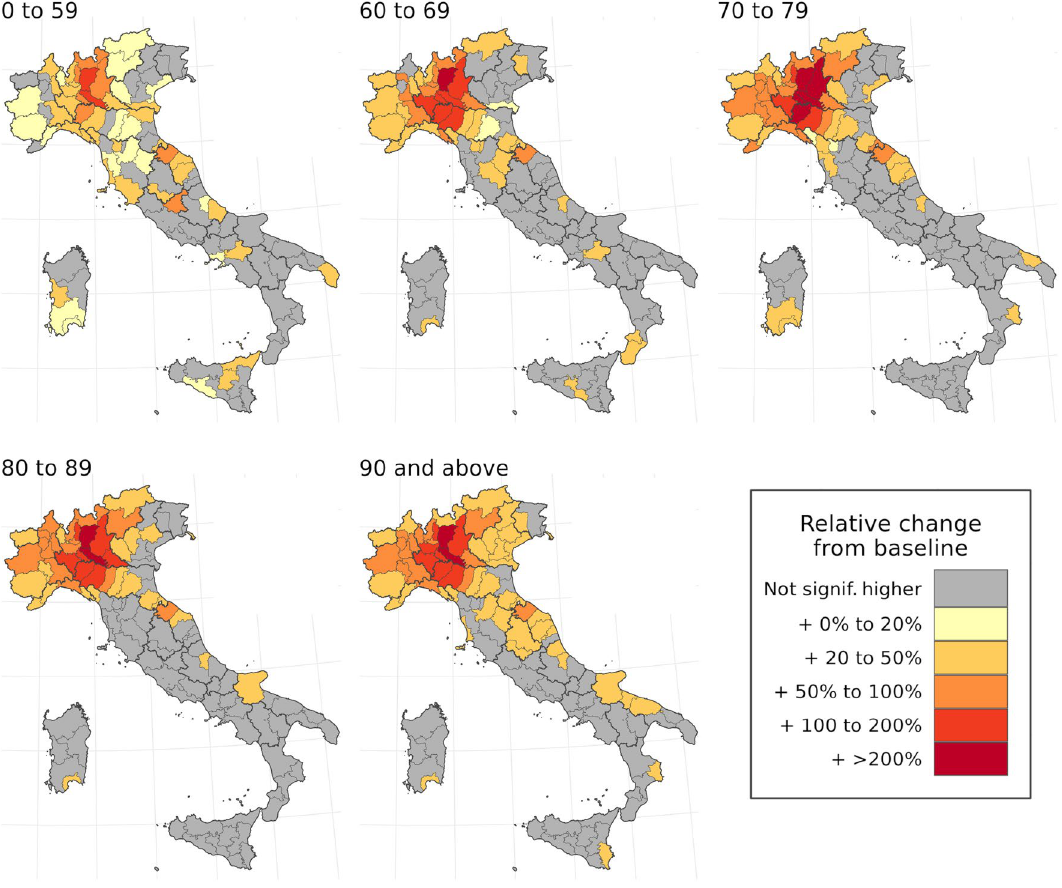
Figure 4. Map of standardized mortality ratios by age group and province over the entire period of March through May 2020. In these figures, significance is defined as falling outside of the 95% uncertainty interval for baseline mortality for a given age group and province during this Figure 4 maps the standardized mortality ratio, or the ratio between observed and baseline mortality rates, by age group and province across the entire 13-week period from 26 February through 26 May 2020. Note that the standardized mortality ratio uniformly increases across the northern provinces of Italy when moving from the 0–59 age group to the 60–69 and 70–79 age groups, and remain heightened in the oldest age groups, with some provinces in Lombardy and Emilia Romagna experiencing over three times the expected baseline mortality in older age groups. The greater increase in excess mortality among older age groups can also be expressed by com- paring the proportion of excess mortality with each age group with that age group’s share of all-cause mortality in the years 2015 through 2019. Adults over age 60 accounted for 92.6% of all deaths in the years 2015–2019 (2.99 million deaths out of 3.23 million total), but 97.0% of all excess mortality in March through May of 2020 (51,600 of 53,200 excess deaths). Similarly, adults over age 80 experienced 63.4% of all deaths in previous years (2.04 million deaths out of 3.23 million), but 68.4% of excess mortality (36,400 of 53,200 excess deaths). Spatial concentration. This model is also able to characterize spatial variation in excess mortality during